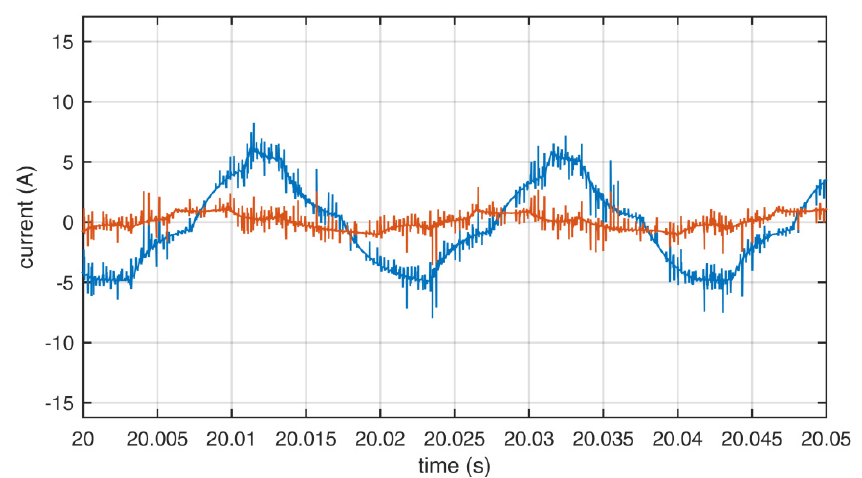
Figure 11. Output currents of the inverter using set A. Blue—L1, red—L2.